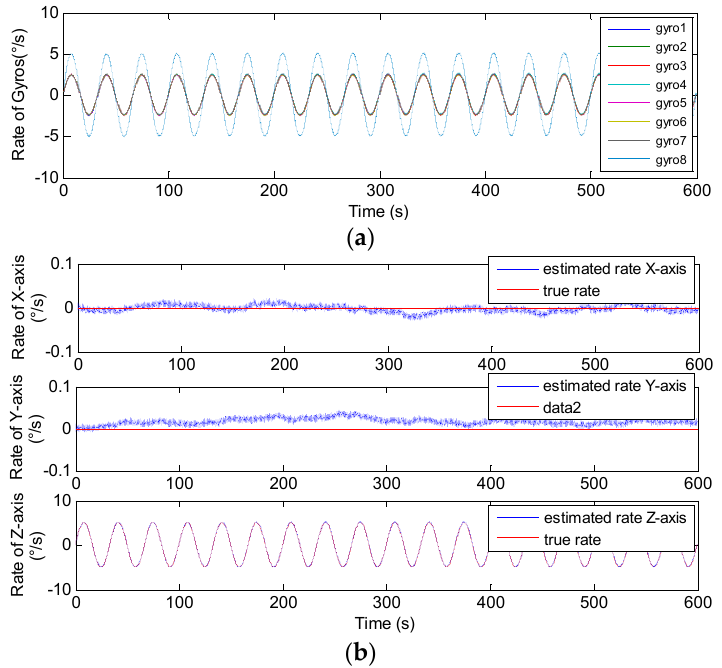
Figure 18. Sinusoidal results of the 6-gyro MIMU system for scheme 2. ( a ) The outputs of the gyros. ( b ) The estimated results of the MIMU.